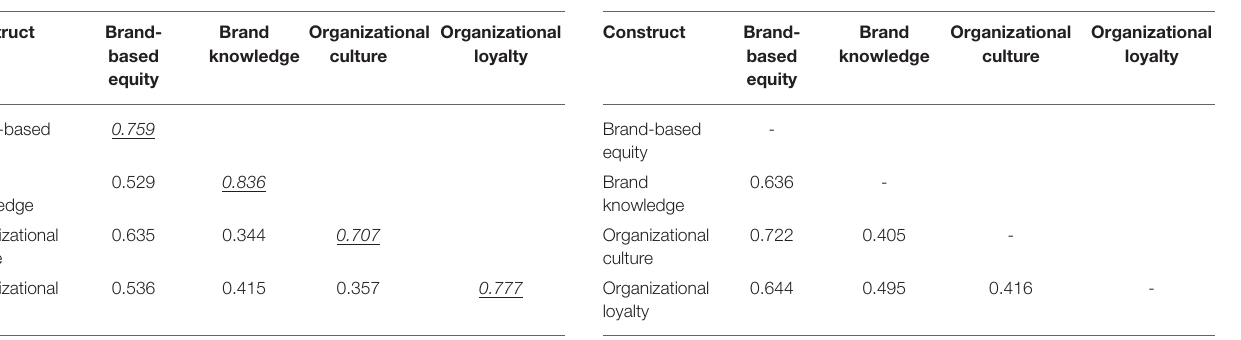
TABLE 3 | Discriminant validity (Fornell-Larker